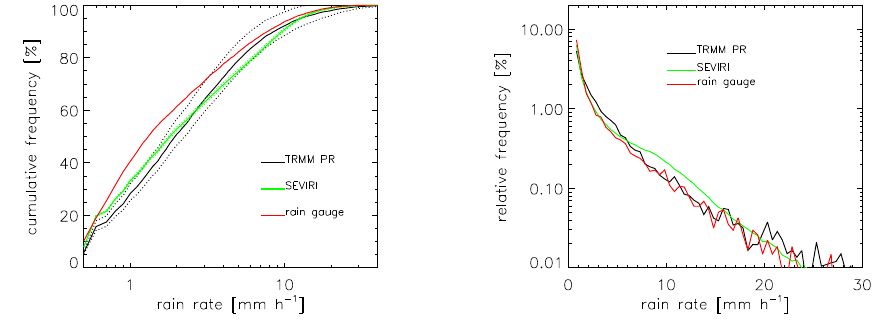
Fig. 4. (Left) cumulative frequency distribution of rain rate derived from (black) TRMM-PR, (green) SEVIRI using CPP-PP, and (red) daytime (07:30–16:30 UTC) rain gauge observations from the selected stations shown in Figure 2. Note the logarithmic scaling on the x -axis. The accompanying dotted lines for TRMM-PR and SEVIRI denote the standard deviation at each rain rate bin, which was obtained from a bootstrapping technique using 10000 draws. (Right) corresponding relative frequency distribution for TRMM-PR, SEVIRI, and rain gauge with logarithmic scaling on the y -axis. Results are shown for 10 ◦ W–10 ◦ E, 0 ◦ –20 ◦ N.